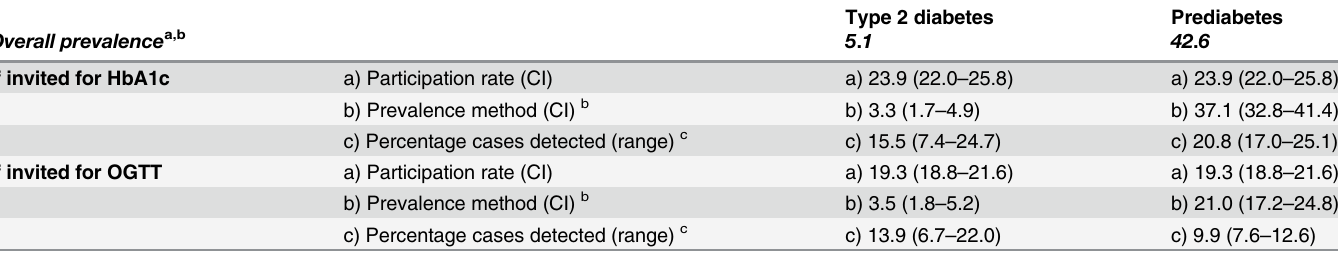
Table 4. Estimation of the percentage of the total of cases with type 2 diabetes and prediabetes in the population detected in a 18 – 60 year old South Asian population in The Hague. Overall prevalence = prevalence based on combined OGTT and HbA1c measurement. OGTT = oral glucose toler- ance test; HbA1c = glycated hemoglobin measurement; CI = 95%- confidence interval.